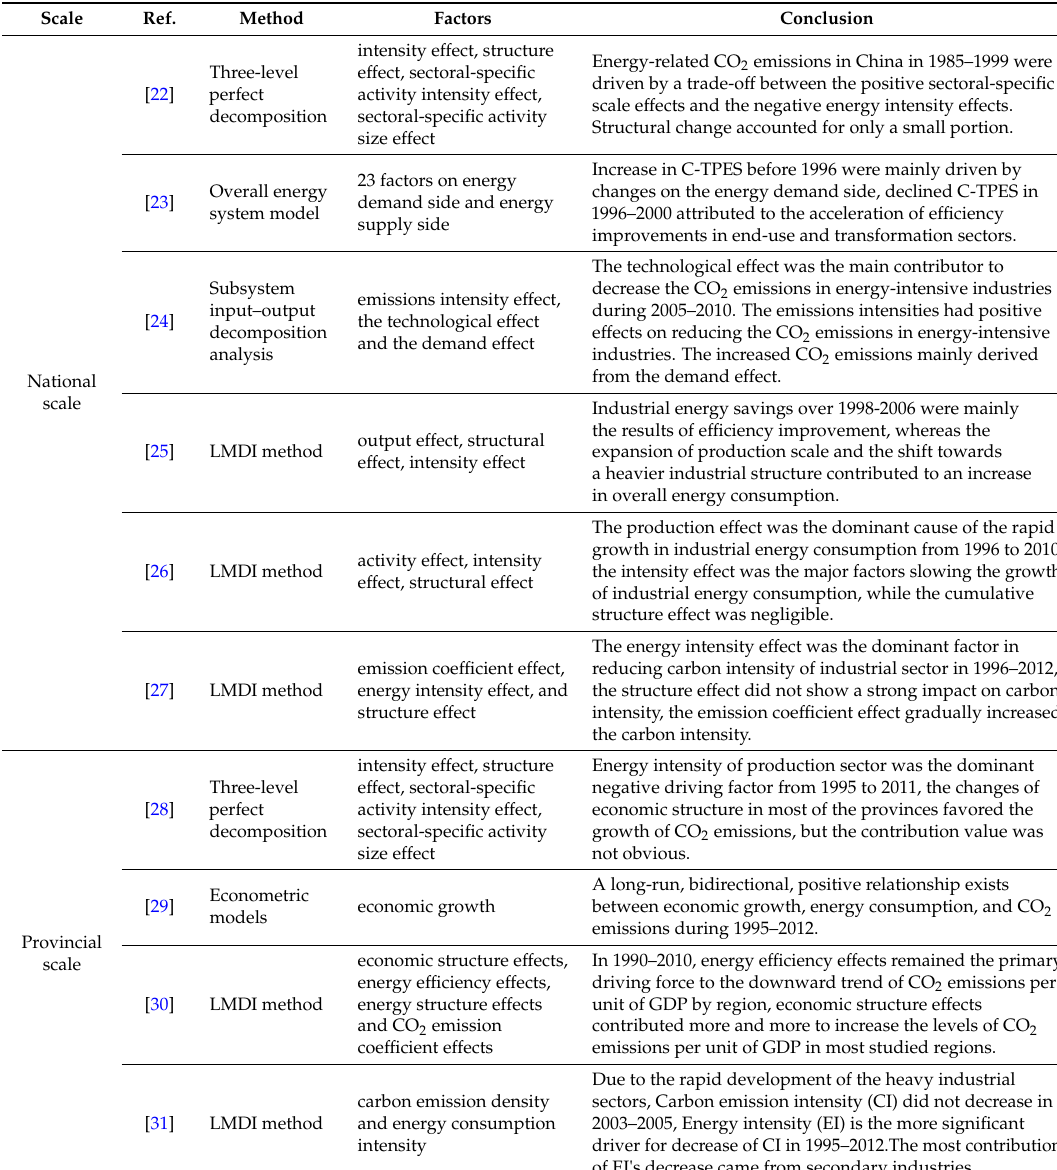
Table 1. Summary of drivers on energy consumption and carbon emission of China’s economic sectors.